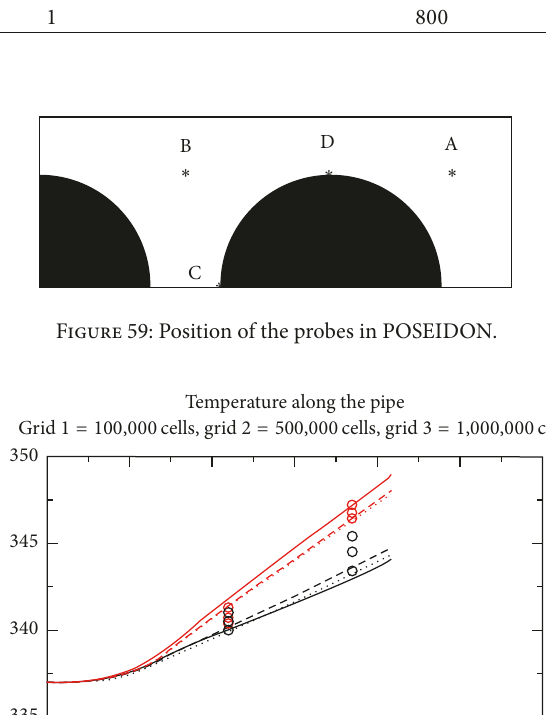
Figure 58: ASU axial liquid velocity with the new and standard models.